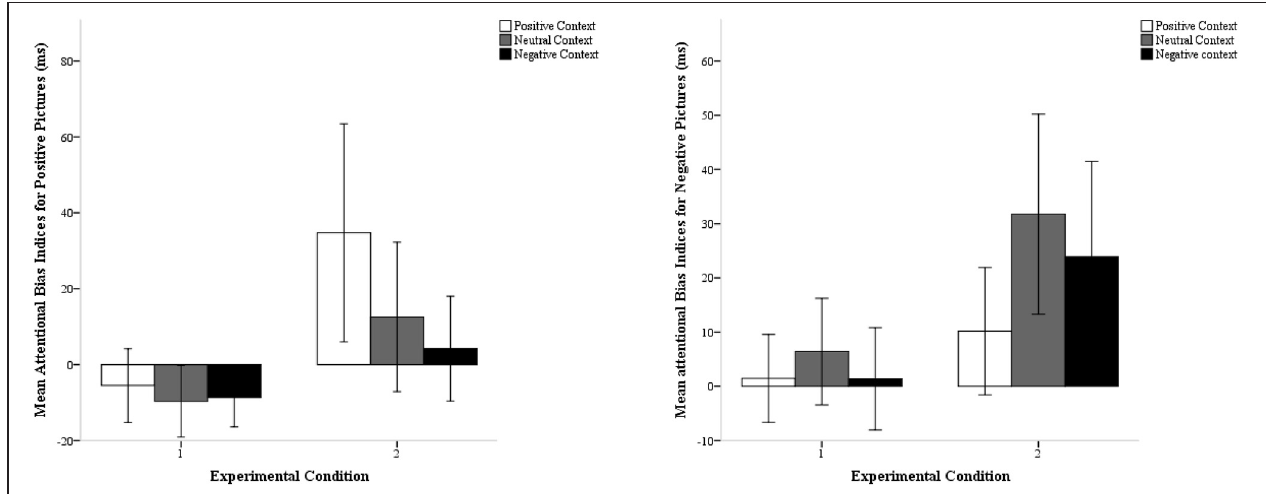
FIGURE 2 | Mean attentional bias indices for positive pictures and negative pictures as a function of sound valence (positive, neutral or negative) in both experimental conditions. Error bars represent 95% confidence intervals.